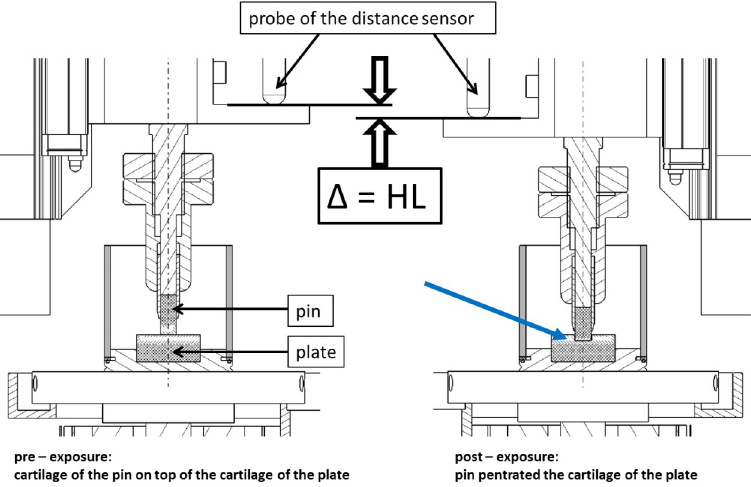
Fig 3. Technical sketch of how the height loss ( Δ = HL) of the cartilage layers was measured under tribological exposure of the osteochondral pin and plate. It was measured with the distance sensor shown in Fig 1. The blue arrow indicates the pin penetrating the surface of the plate. Note: both cartilage layers lost